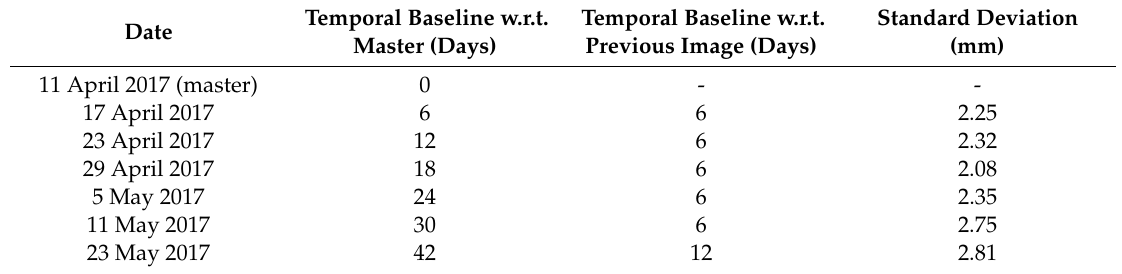
Table 4. Deviation between Phase Linking-derived APS and SqueeSAR-derived